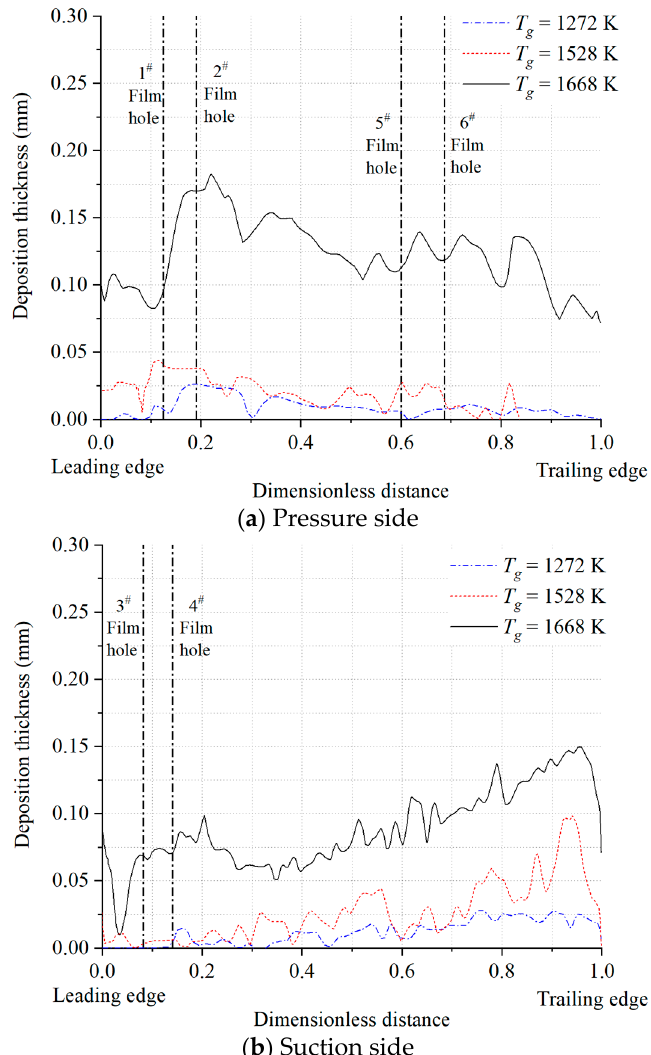
Figure 15. Surface deposition thickness plot for the test model at gas temperatures of 1272, 1528 and 1668 K (cross-section at midspan).